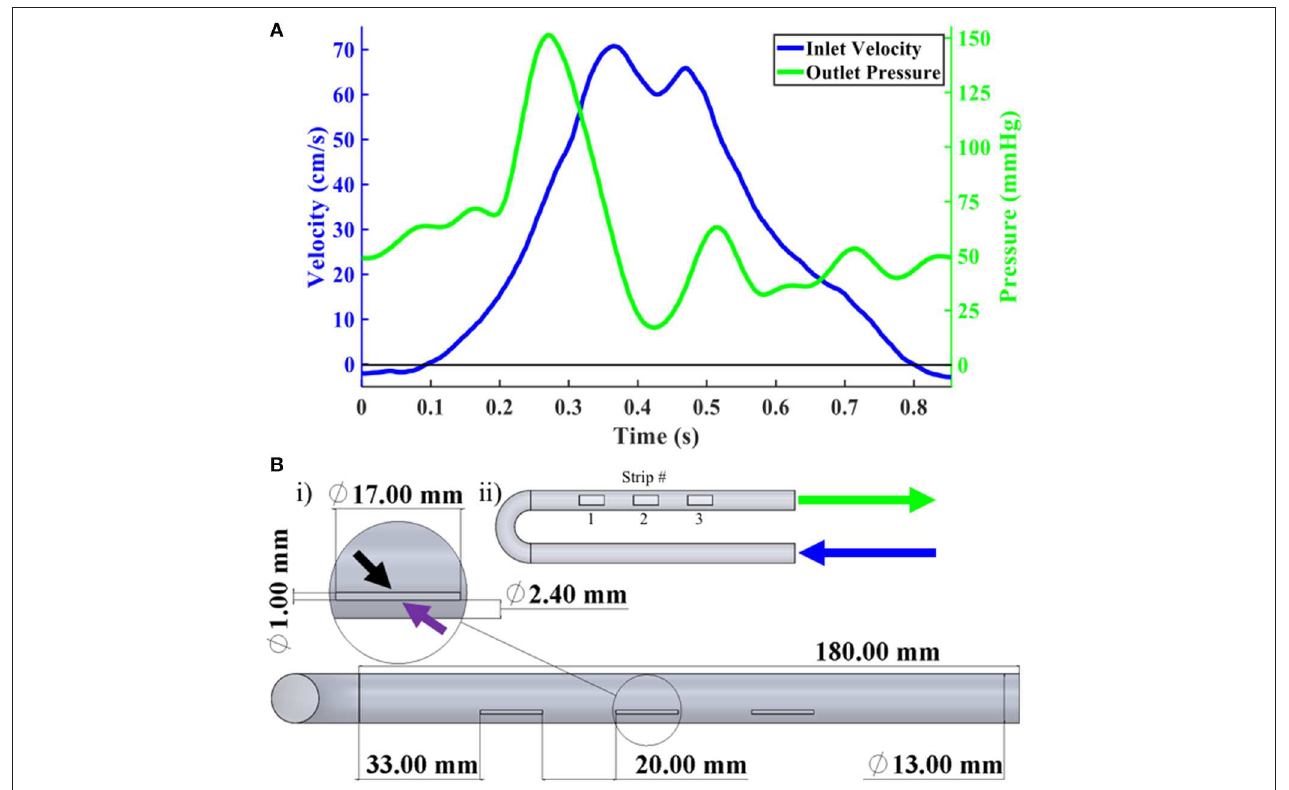
FIGURE 1 | Boundary conditions and FSF Bioreactor CAD. (A) i) Overall CAD geometry of FSF bioreactor primarily showing the three scaffold strip locations. Magnified inset showed one of the scaffold strips with the black and purple arrows pointing to the proximal and distal sides, respectively. ii) Scaffold strip numbering designation as well as arrow labels showing inlet (blue) and outlet (green), which correspond with the information from (B) regarding their respective velocity and pressure profiles. (B) Velocity (blue), in cm/s, and pressure (green), in mmHg, waveforms recorded by our flow probe and pressure